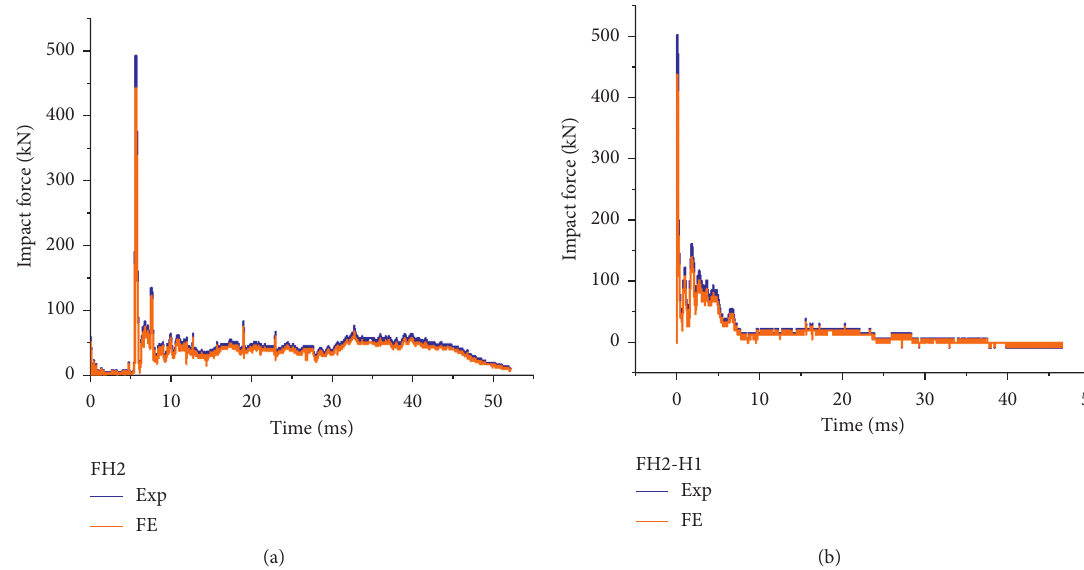
Figure 6: Time history curves of the impact force. (a) Unstrengthened specimen. (b) CFRP-shear-strengthened